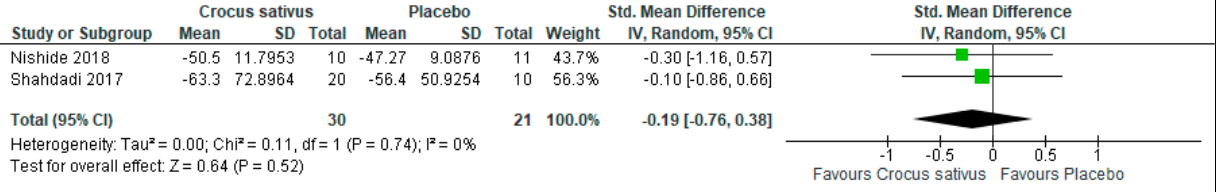
Figure 11. Forest plot for the outcome anxiety level [26,28]. Note: Line indicates confidence interval and the green square indicates effect estimate. Black diamond indicates cumulative effect estimate and its confidence interval.